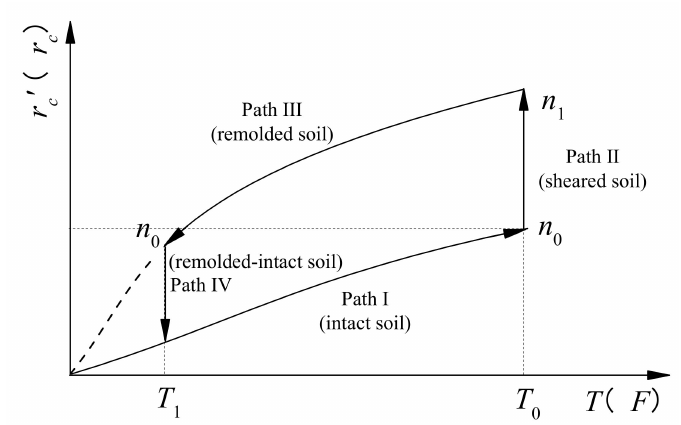
Figure 11. Shear path during shield